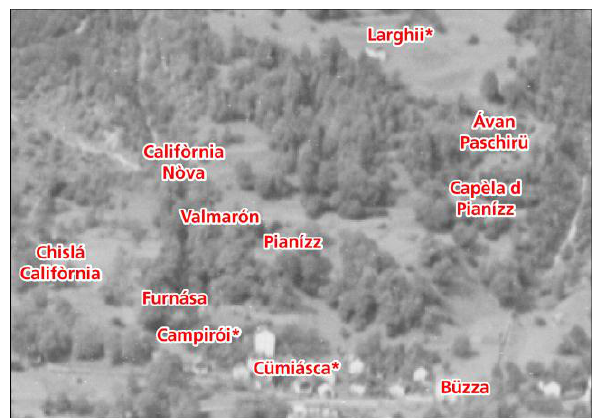
Figure 5: Precise localization of place names on a historical terrestrial picture. Most sites are perfectly recognizable in their original shape before the abandonment of traditional